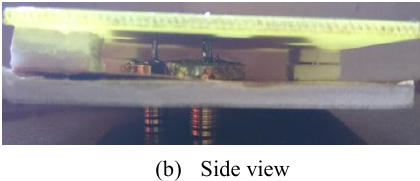
Figure 3. Fabricated prototype antenna